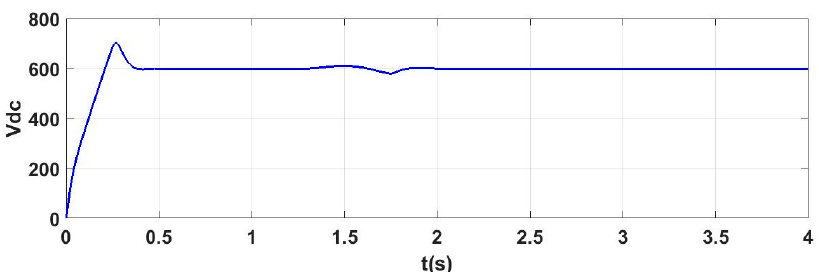
Figure 11. Output frequency of PLL, affected by optimal levels for micro-grid and network parameters.